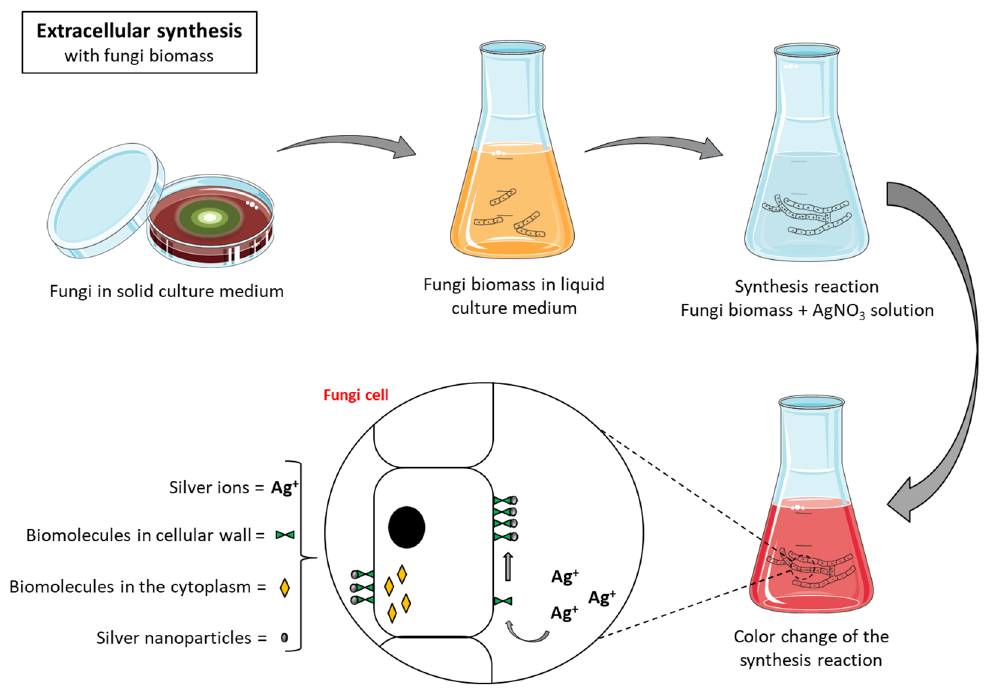
Figure 3. Extracellular biosynthesis of silver nanoparticles with fungal biomass. The synthesis of silver nanoparticles through aqueous extracts of microorganisms occurs through the action of biomolecules present in these extracts, derived from the biomass of the microorganisms (Figure 4). Thus, the nanoparticles form in a medium free of undesirable components. This is the most used method for the synthesis of silver nanoparticles using microorganisms [34].